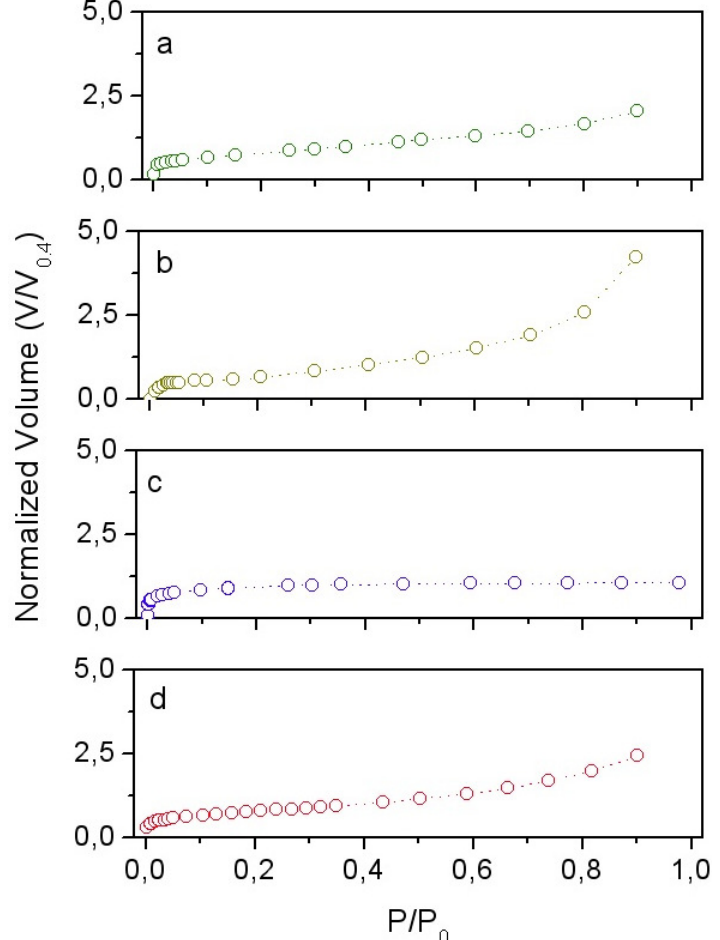
Figure 7. Normalized nitrogen adsorption isotherms at 77 K for: ( a ) LaNi ( b ) LaNi powder; ( c ) SiO 5 ( b ) 3.6 cm 3 /g; ( c ) 70 cm 3 /g; ( d ) 84.6 cm 3 /g.